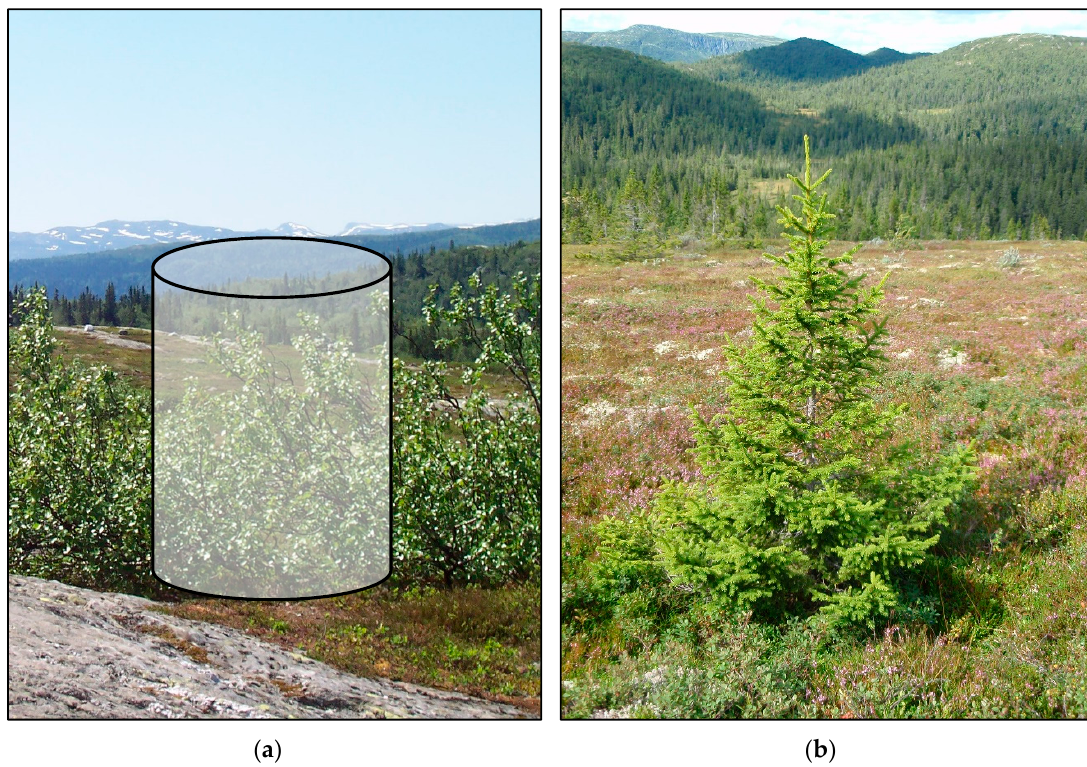
Figure 7. Illustrations of a sample unit for model construction adopted in the current study ( b ) and for future studies, in which a more appropriate representation of the basic population elements is accounted for ( a ). The sample unit to the left in the form of a vegetation cylinder can be viewed as a conventional fixed-area sample plot, in this illustration with a size of 2 m 2 .